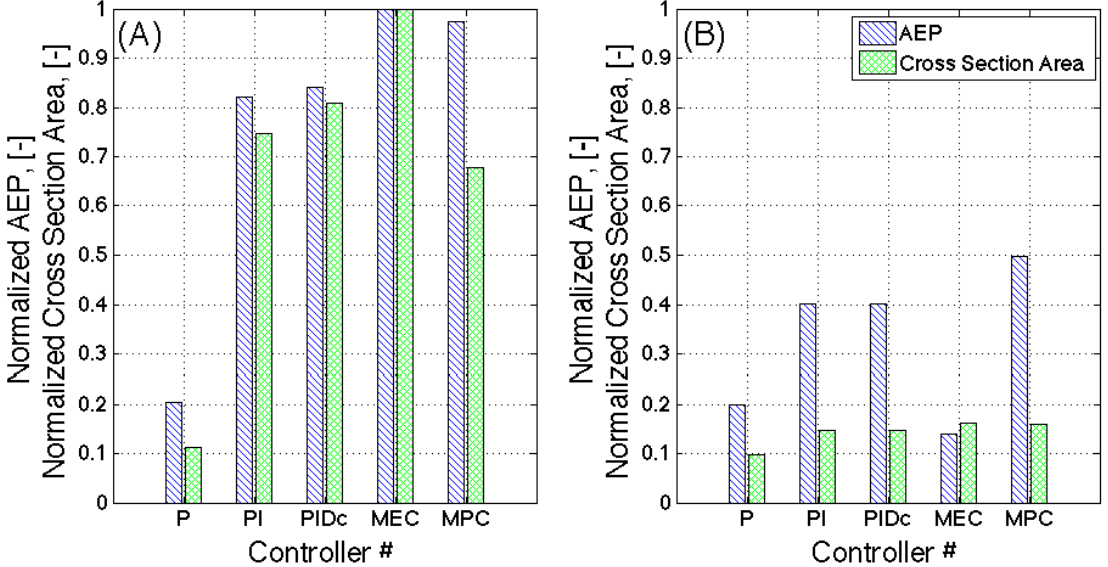
Figure 11. Comparison of AEP (blue) and Cross Section Area (green) between different control strategies, for ( A ) Case 1 and ( B ) Case 3. The data is normalised by the AEP and Cross Section Area of MEC Case 1. The Cross Section Area data refers to the Weld 1